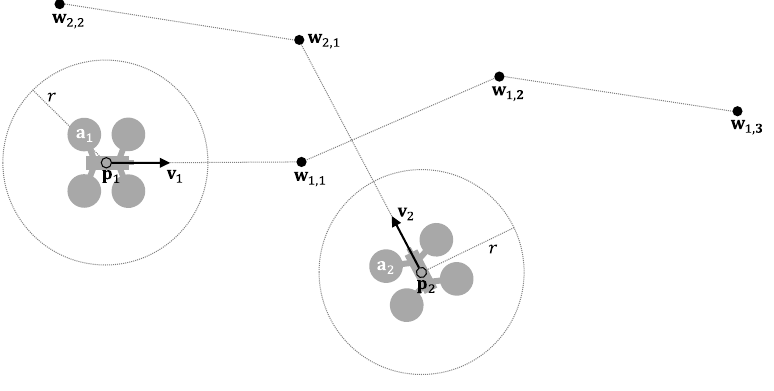
Figure 2. Two UAVs in the airspace.